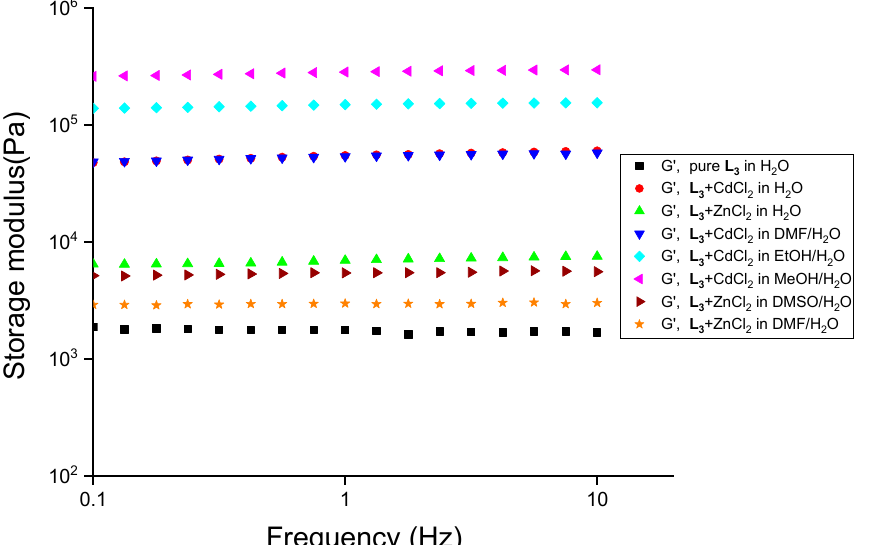
Figure 9. Frequency-sweep experiments with L 3 at 2.0 wt% and in the presence of chloride salts of zinc and cadmium (1.0 equiv.) in various solvent mixtures at 20.0 °C with a constant strain of 0.02%. Similarly, we observed an enhanced mechanical strength for L 3 gels at 2.0 wt% with 1.0 equivalence of ZnCl 2 in water (~4.4-fold), DMF/water (~1.8-fold), and DMSO/water (~3.3-fold) (Figure 9).